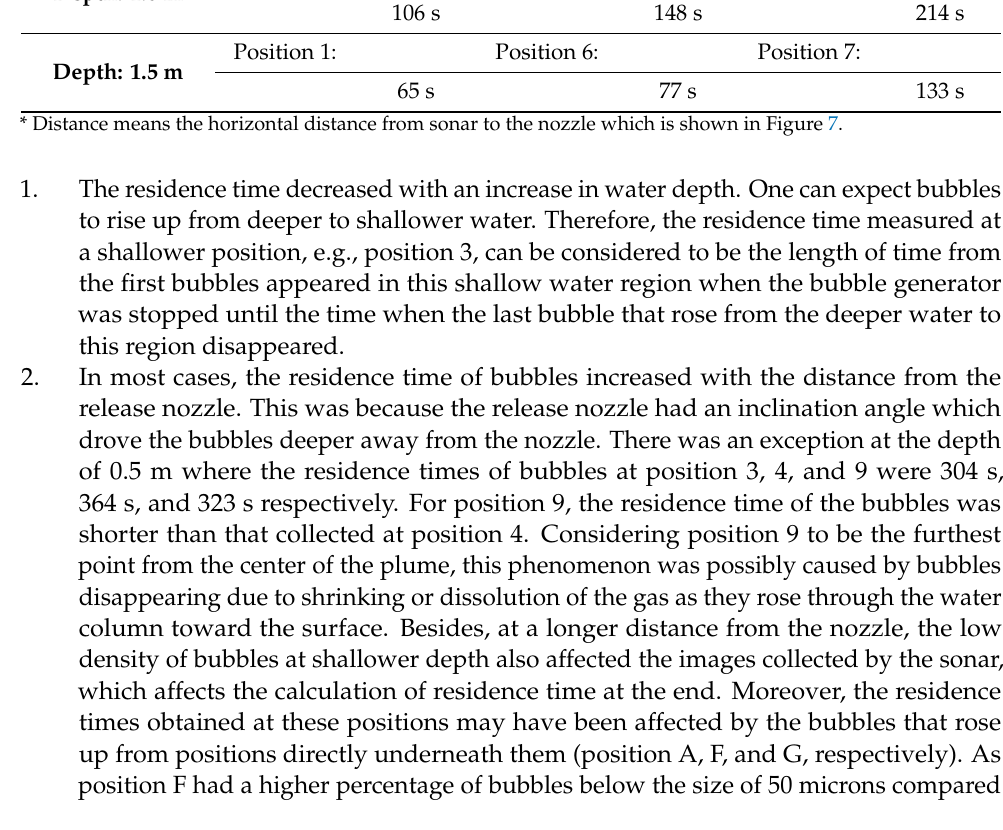
Figure 13. Sketch of the area that was used to measure the residence time of bubbles detected by the sonar at sampling point 1.